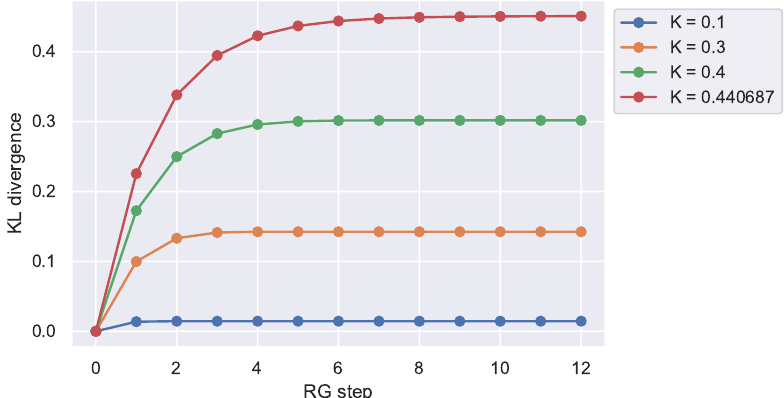
Figure 3: The normalized relative entropy of the 2d classical isotropic Ising model as a function of decimation step for values of the nearest-neighbor coupling K < K within the α -extended Maris-Kadanoff approach (45) with α = α ∗ in (46). The